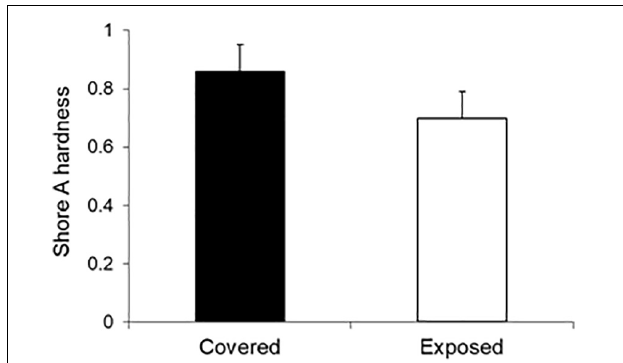
FIGURE 8 | Substrate hardness of the mussel-covered and mussel-removal (exposed) benches. Hardness was measured in Shore A units, which range from 0 (low) to (1) high. The vertical lines above the bars indicate 1 SD. Differences among treatments were significant ( p <